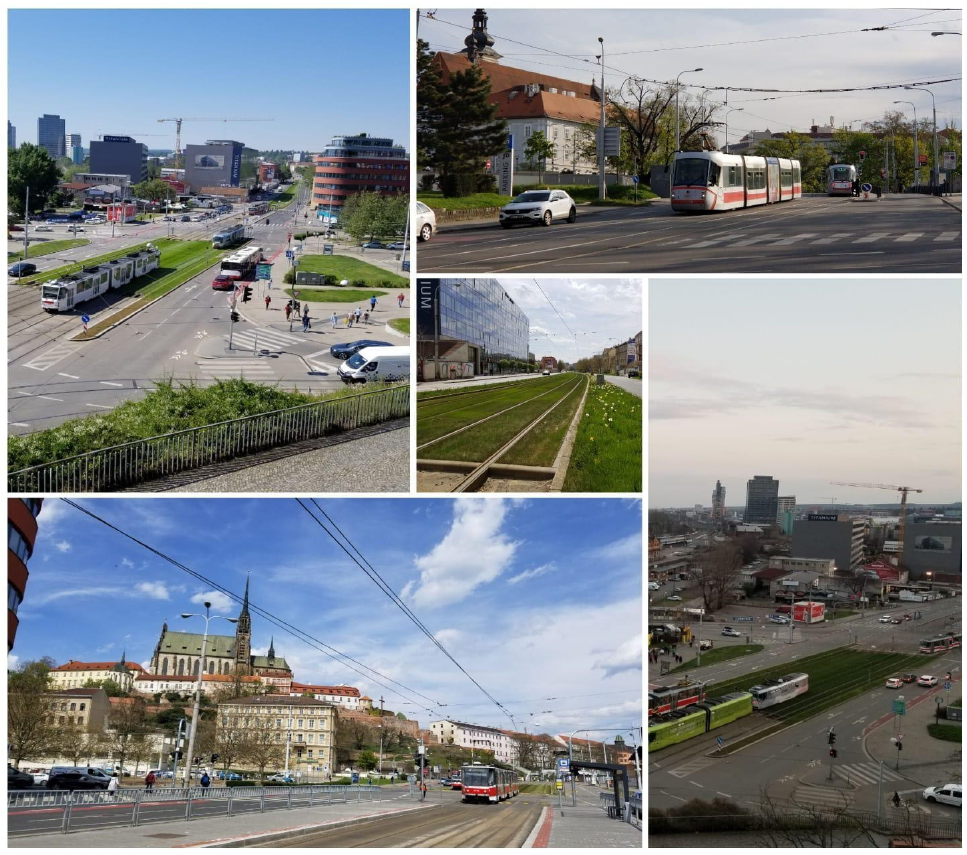
Figure 5. Brno city Tramlines, trams, and greenery on the tram lines (Photos: Dastan Bamwesigye).